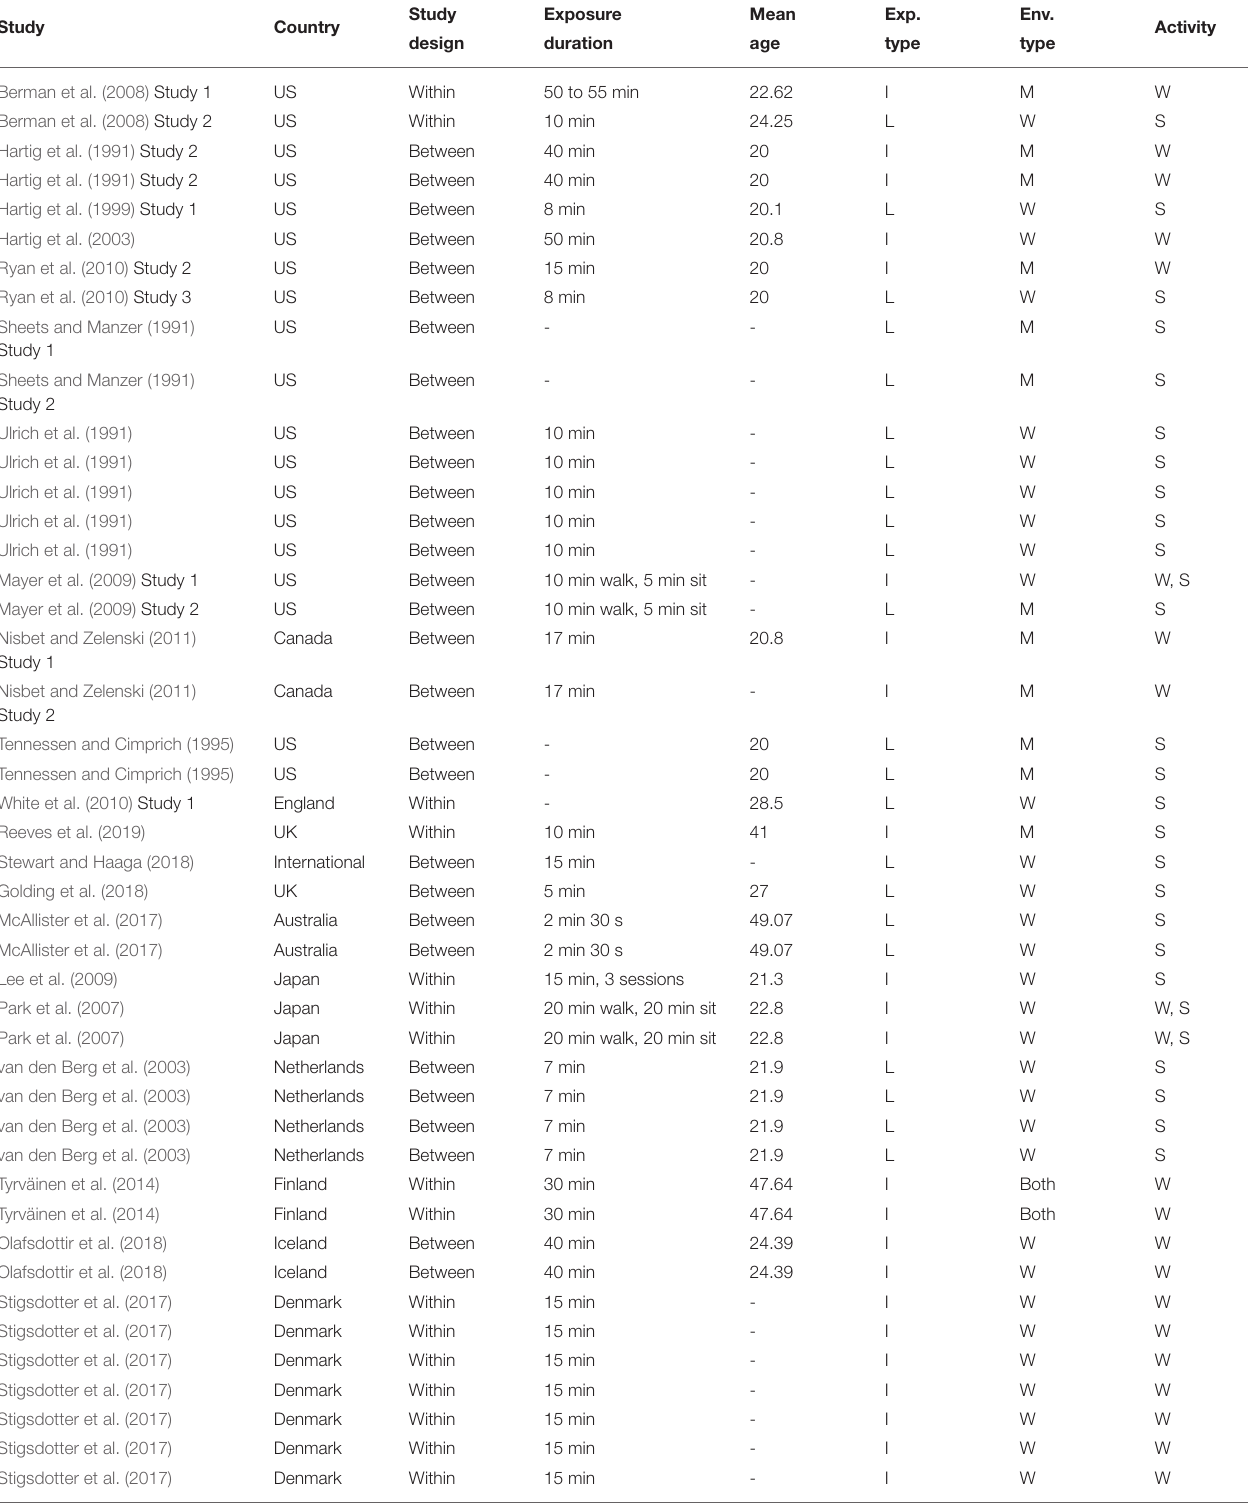
TABLE 1 | Summary of metadata from experimental studies reporting on the relative effect of exposure to natural and urban environments on positive and negative affect.